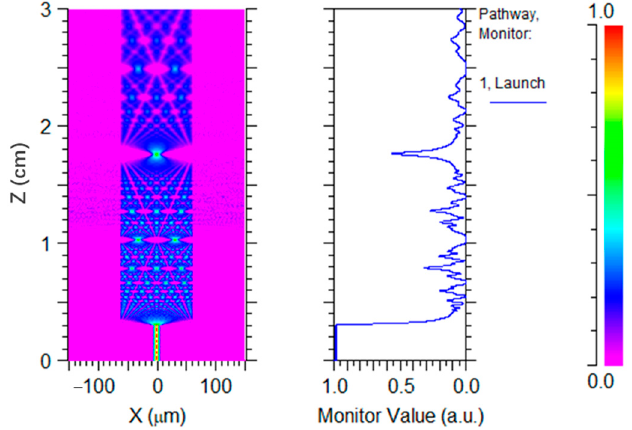
Figure 3. Simulation analysis of the light propagation in an SMF-NCF structure.